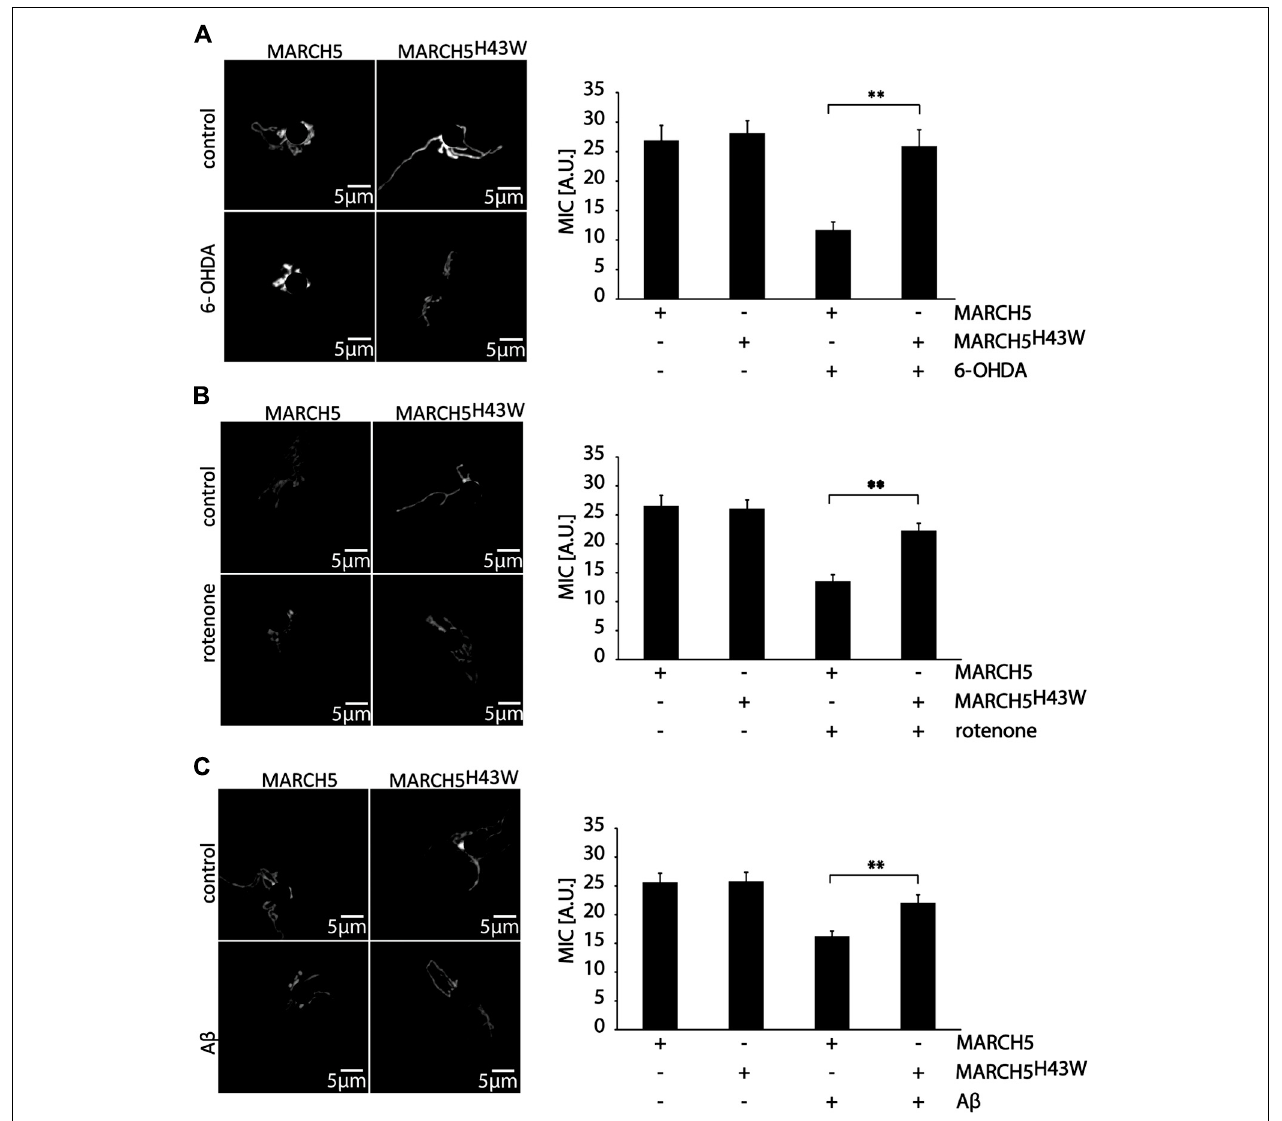
FIGURE 3 | Inactive MARCH5 supports mitochondrial interconnectivity under neurodegenerative stress conditions . SH-SY5Y co-transfected with expression plasmids for PA-GFP and either MARCH5 or MARCH5 H43W were treated with 75 μ M 6-hydroxydopamine for 6 h (A) , 5 μ M rotenone for 6 h (B) , or 25 μ M A β peptide for 24 h (C) and mitochondrial interconnectivity was